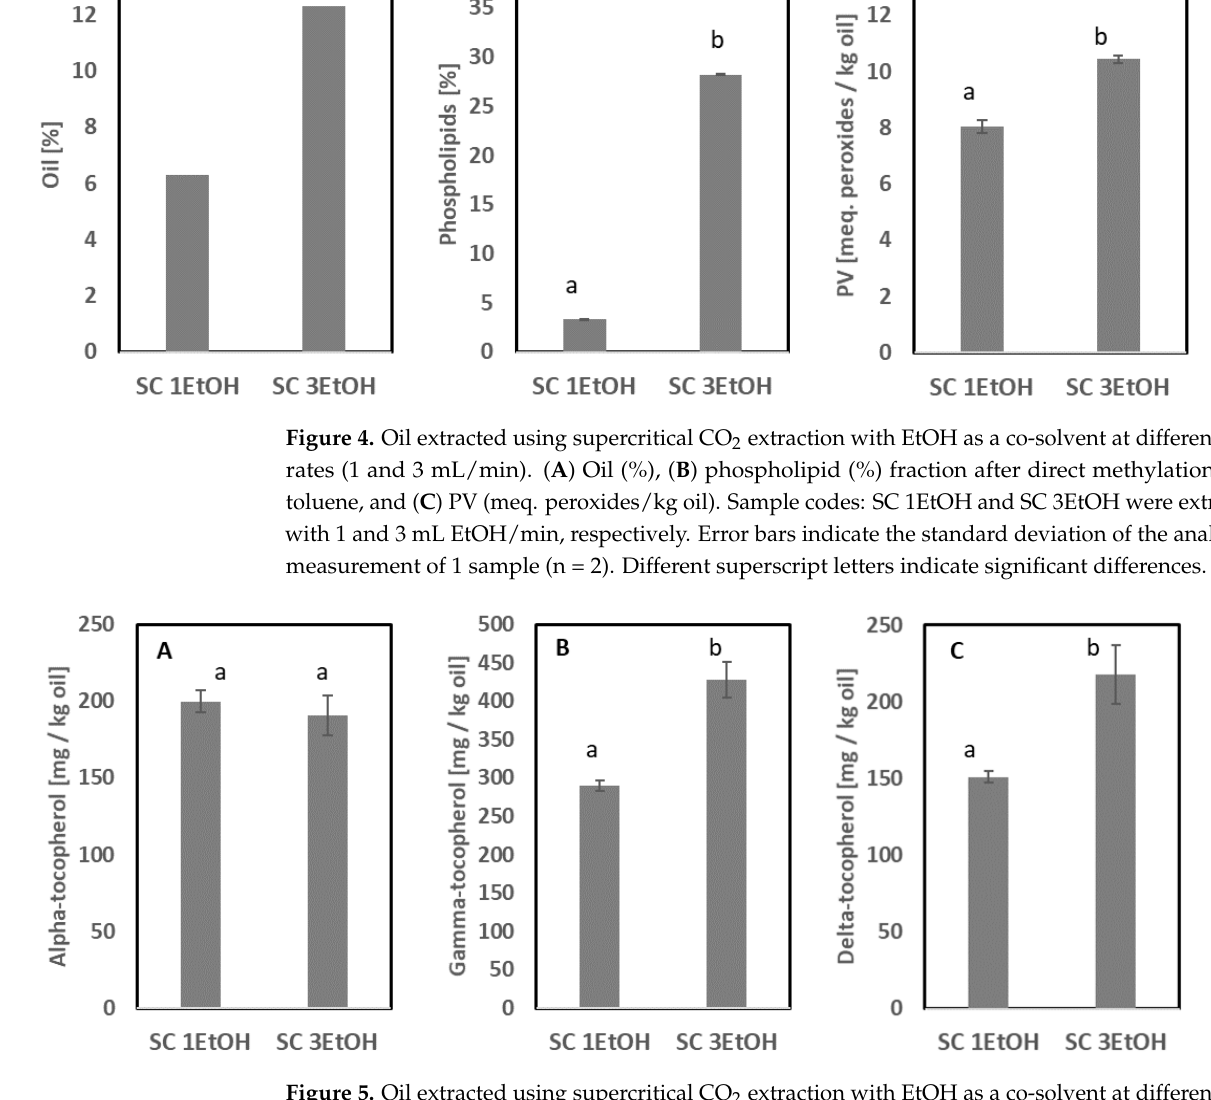
Figure 5. Oil extracted using supercritical CO 2 extraction with EtOH as a co-solvent at different flow rates (1 and 3 mL/min). ( A ) Alpha-tocopherol, ( B ) gamma-tocopherol, and ( C ) delta-tocopherol (mg/kg oil). Sample codes: SC 1EtOH and SC 3EtOH were extracted with 1 and 3 mL EtOH/min, respectively. Error bars indicate the standard deviation of analytical measurement of 1 sample (n = 2). Different superscript letters indicate significant differences.